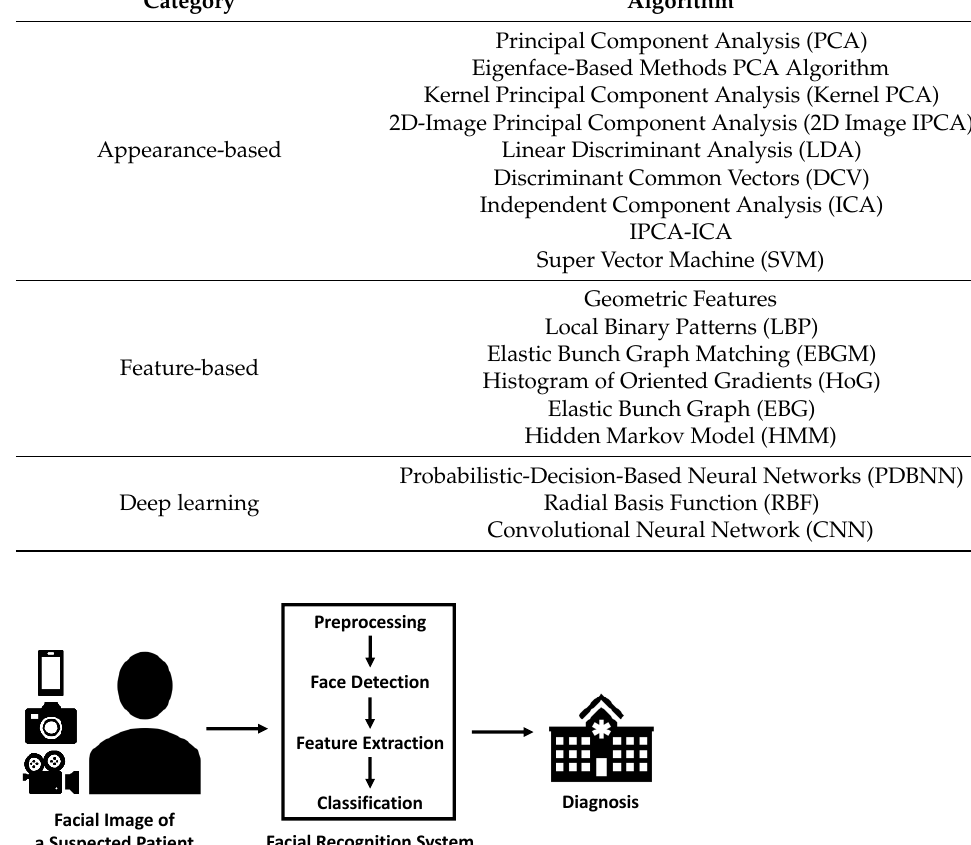
Table 1. Facial Analysis Algorithms.